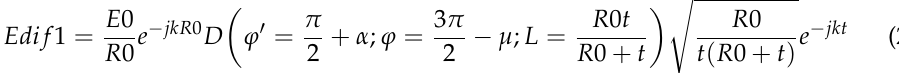
Figure 3. First single diffraction (Edif1) of the considered LOS scenario.